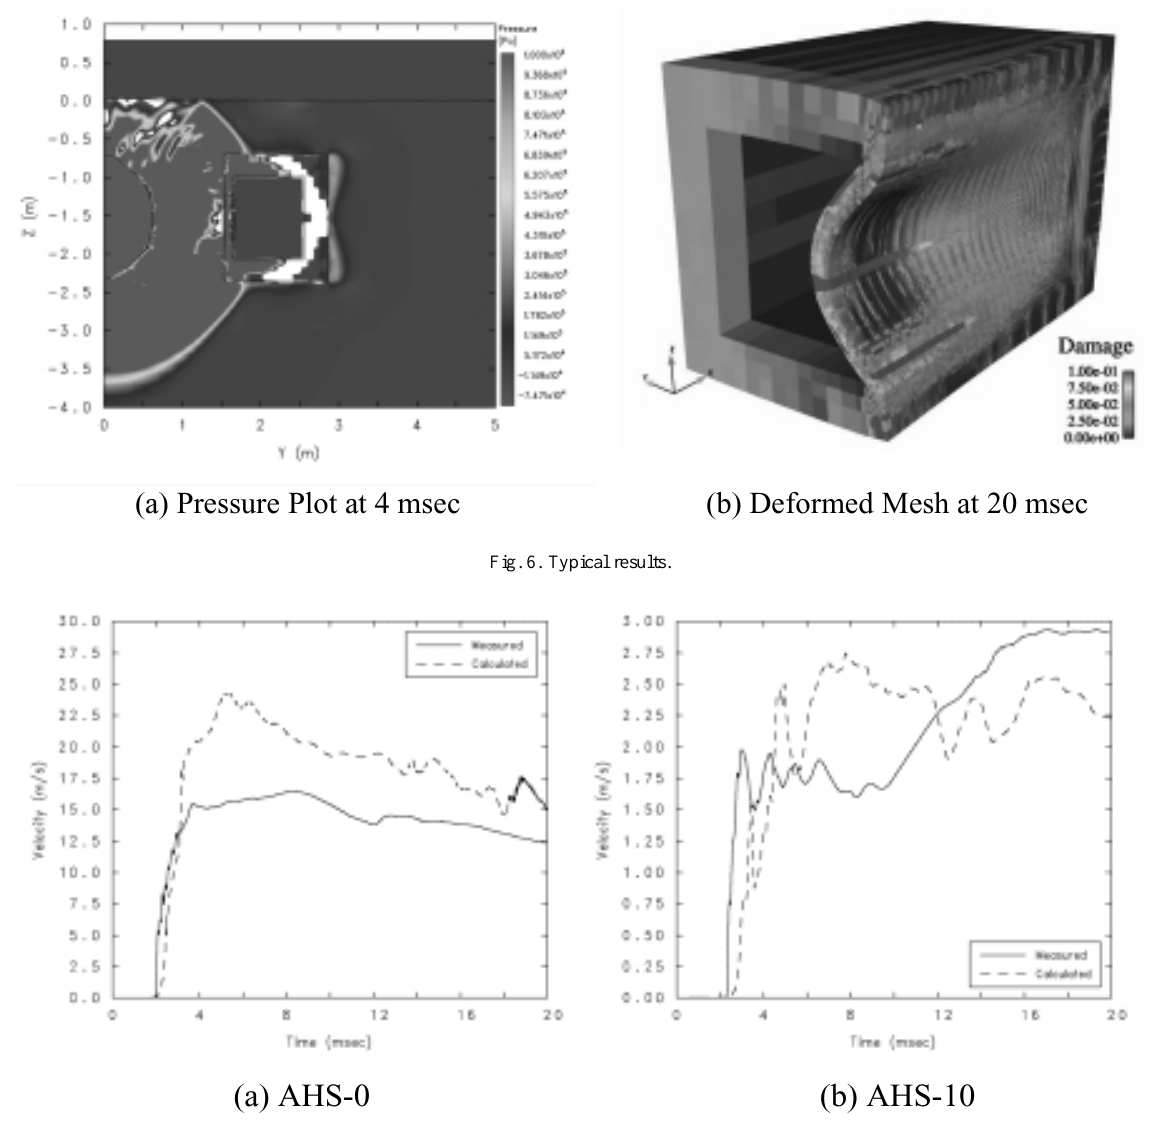
Fig. 7. Velocity at accelerometer locations AHS-0 and AHS-10, Test